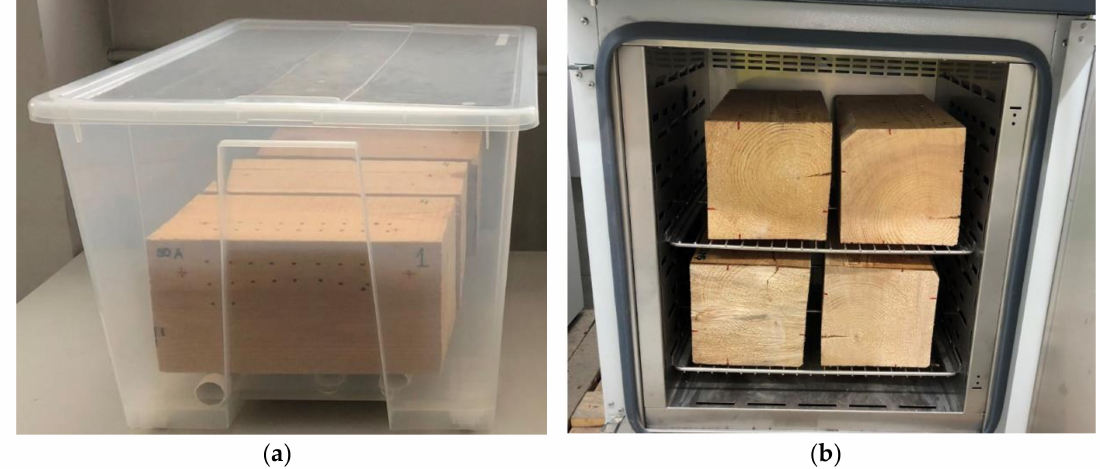
Figure 2. Seasoning of samples: ( a ) moisture-rise chamber; ( b ) wood-drying